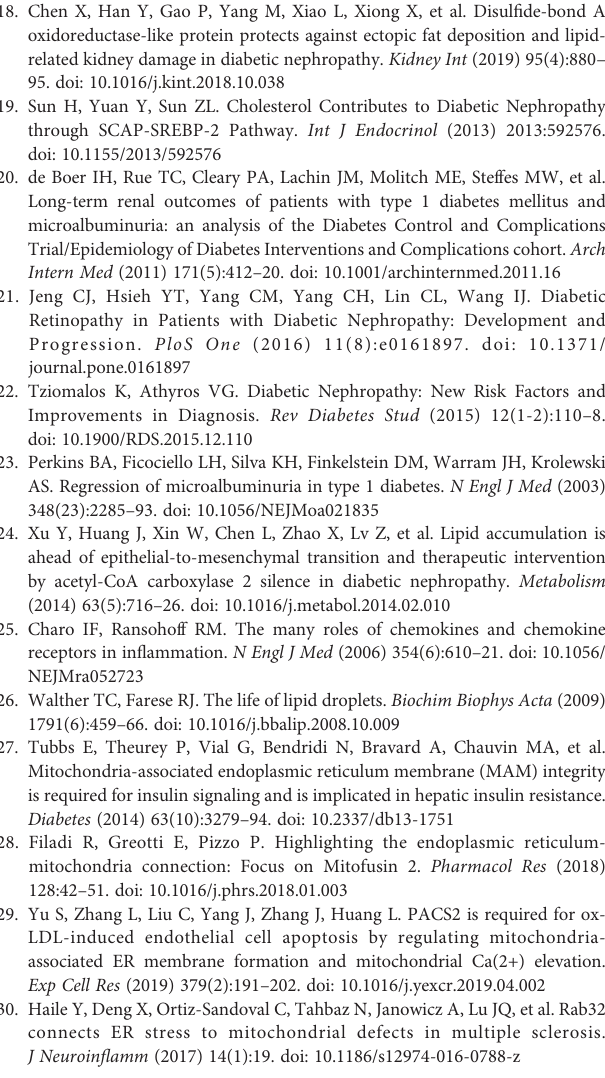
Supplementary Figure 3 | Altered MAM integrity and lipid deposition in HK-2 cells. (A) Confocal image with Mito-Tracker and ER-Tracker staining showing MAM integrity in the HK-2 cells. (B) Quantitative analysis of MAMs by a graph. (C) Oil red O staining in the different HK-2 groups. (D) WB analysis of cleaved caspase 3 in the HK-2 cells. The values are the mean±SD. *p < 0.05 compared with the LG group; # p < 0.05 compared with the HG